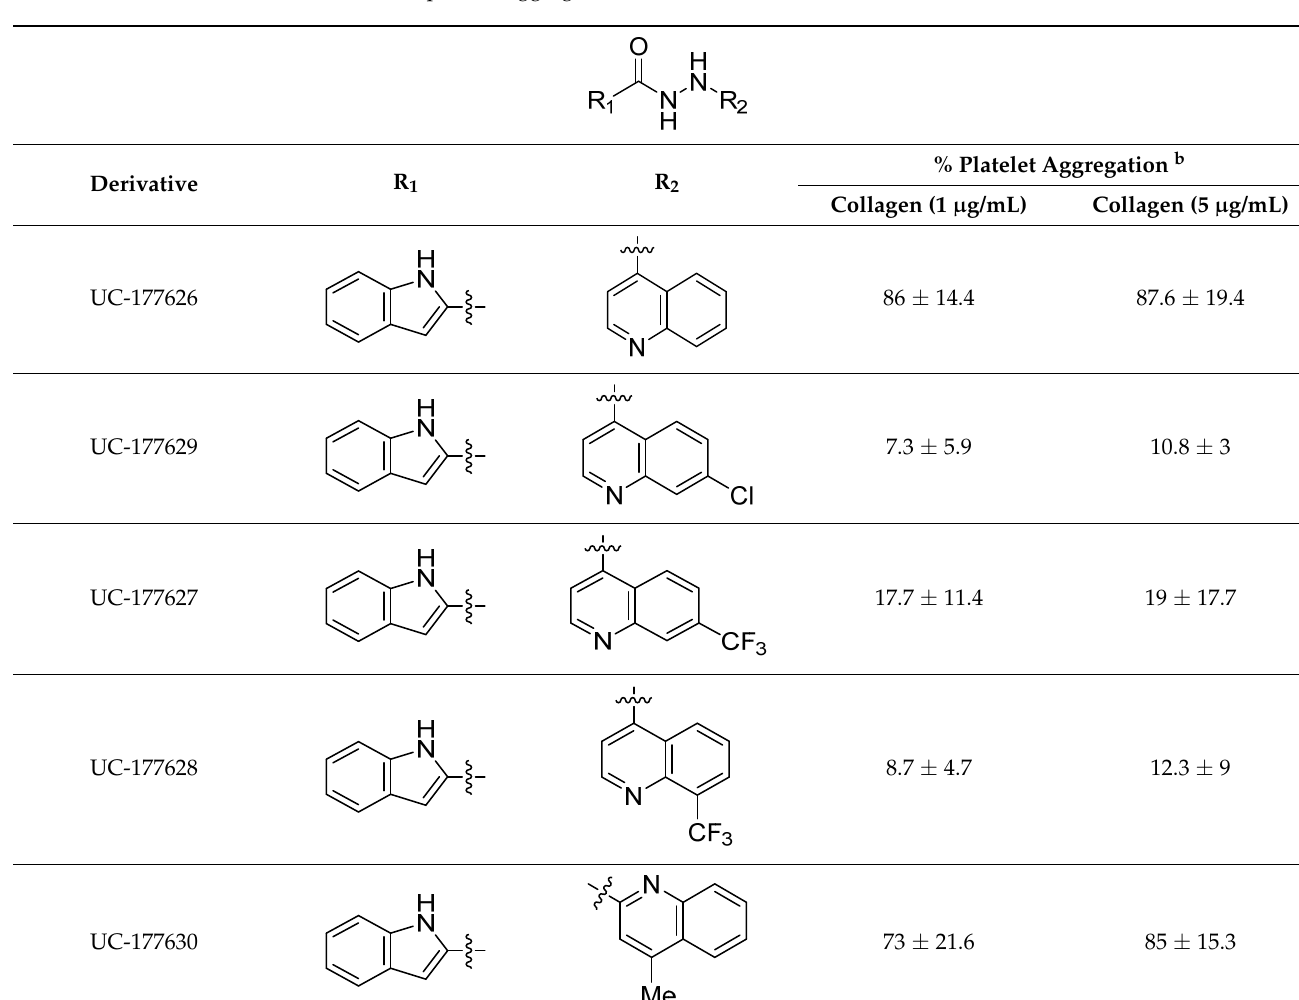
Table 2. Structures of compound UC-177629 analogs and their effects at 20 µM on in vitro collagen- induced platelet aggregation.